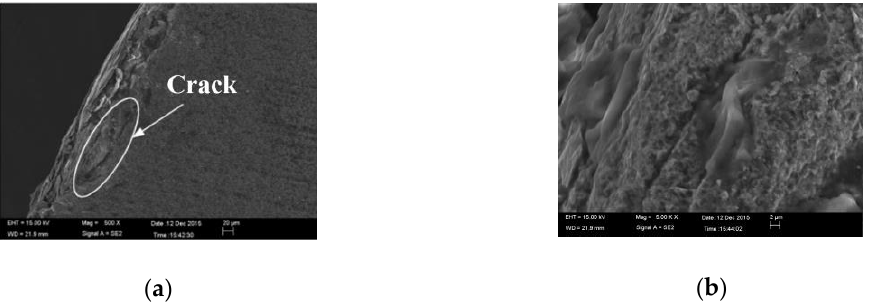
Figure 8. The microscopic morphology of chipping: ( a ) The crack area; ( b ) The magnification of the crack.